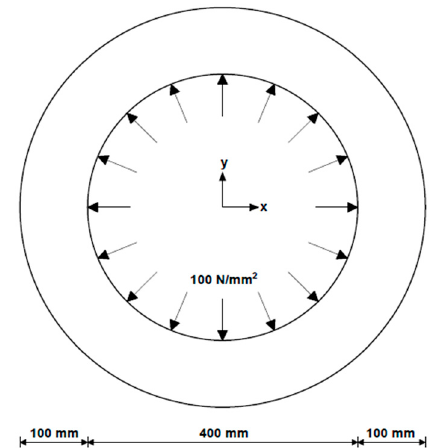
Figure 3. Structure 1: Thick-walled pipe under internal pressure.